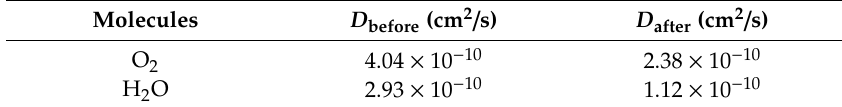
Table 7. Diffusion coefficients of O 2 and H 2 O before and after adsorption of PE by flavor.